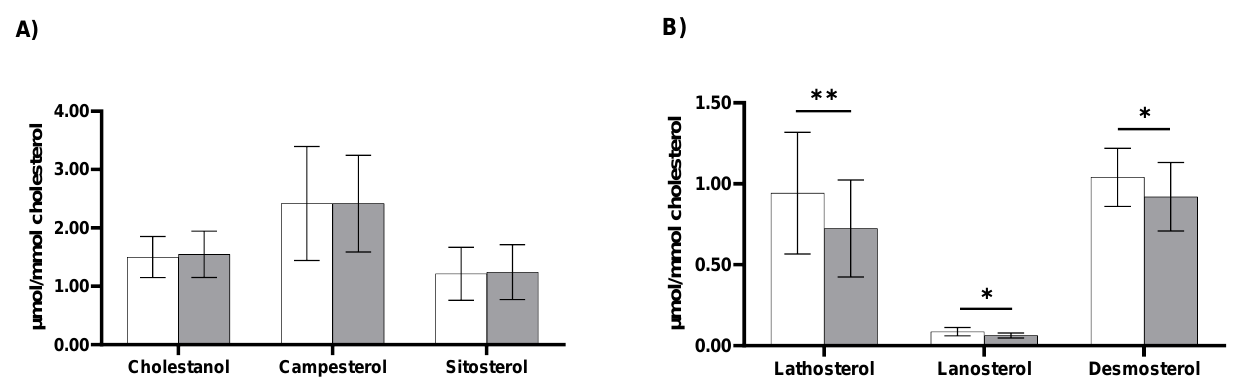
Figure 3. Cholesterol-standardized levels of cholesterol absorption markers (panel ( A )) and choles- terol synthesis markers (panel ( B )) at baseline (white bars) and 24 h after LPS infusion (grey bars) (n = 8). Data are presented as means ± SEM. Significantly different compared with baseline: * p < 0.05; ** p < 0.01.